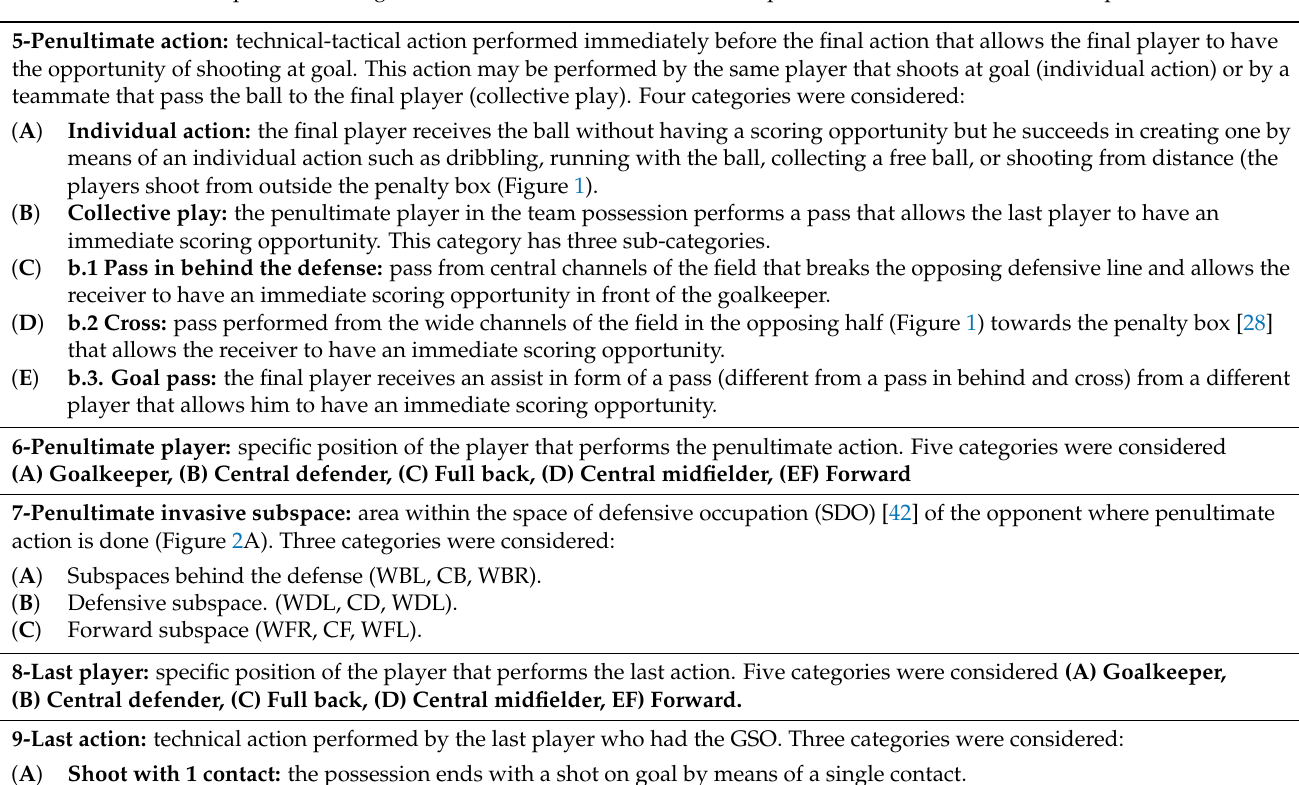
Table 3. Description and categories for the dimensions related to the penultimate and last action of the